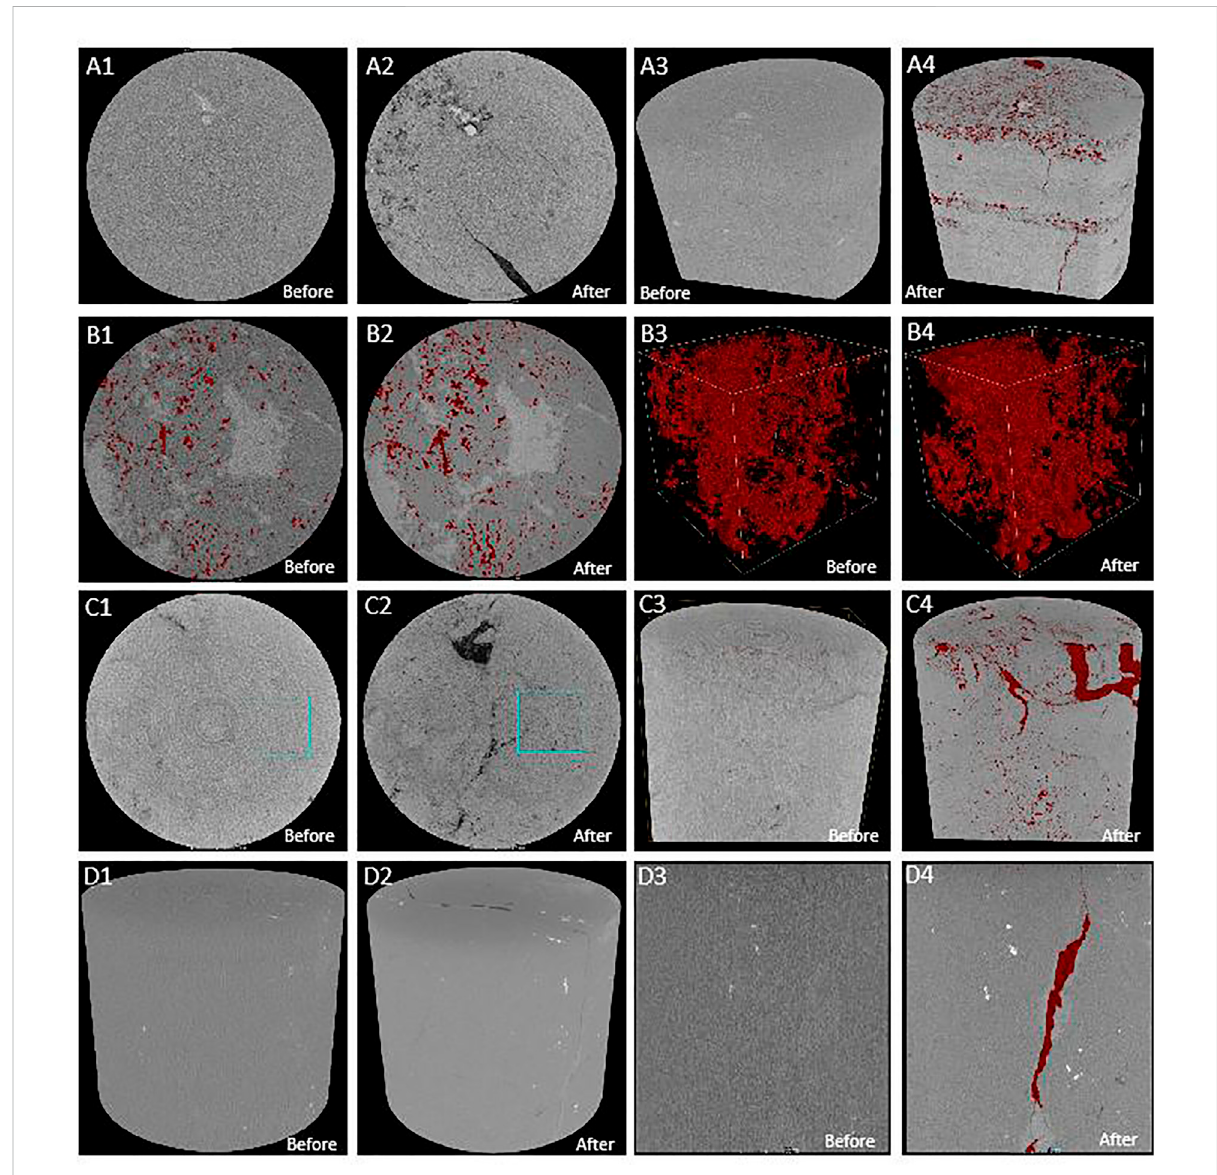
FIGURE 5 Comparison of CT images of the different reservoirs before and after dissolution (A) Comparison of pore structure of dolomitic limestone of MB1 well; (B) comparison of pore structure of residual fi ne-crystalline dolarenite of BT5 well (C) comparison of pore structure of fi ne-crystalline dolostone of XH2 well; (D) comparison of pore structure of medium-crystalline dolostone of YQ6